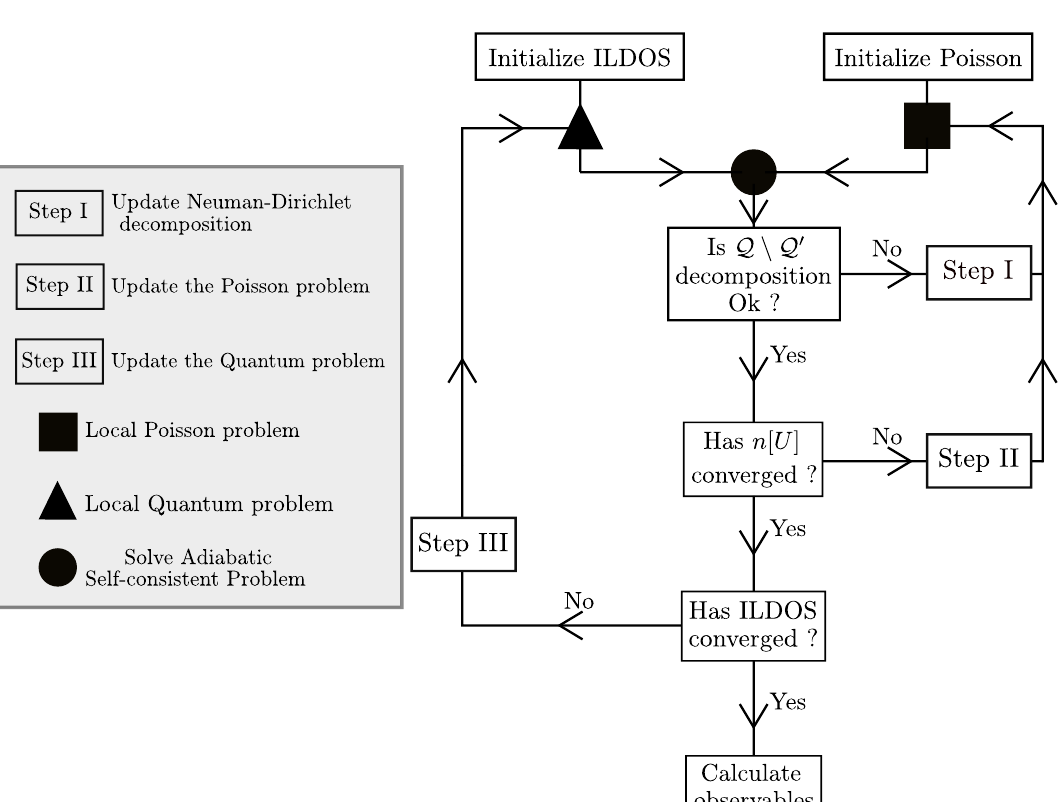
Figure 8: Flowchart for the relaxation steps I , II and III